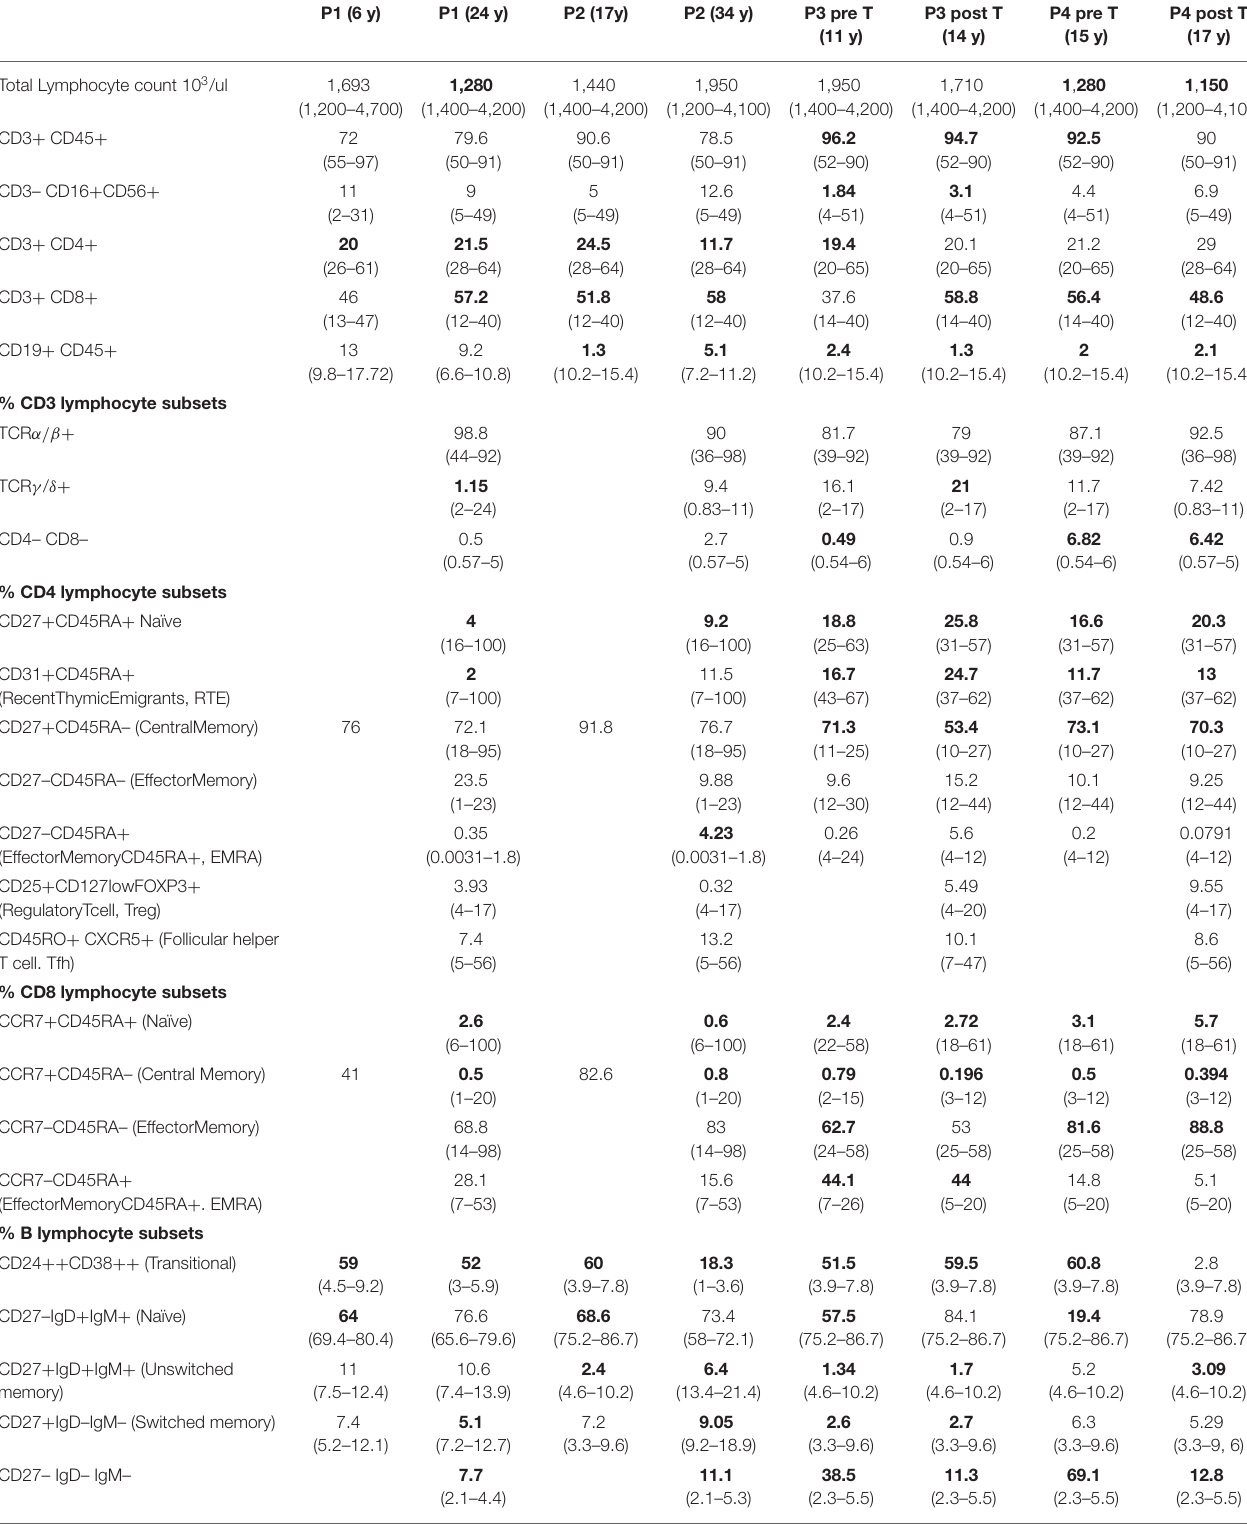
TABLE 1 | Immunological characterization of